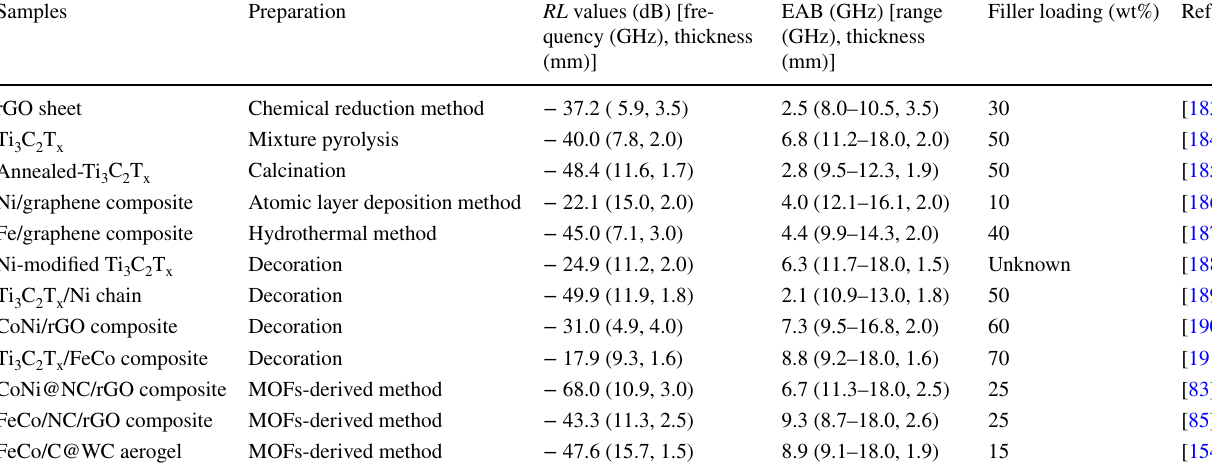
Table 2 Comparison of EM absorption performance for some representative microwave absorbers from various preparation methods